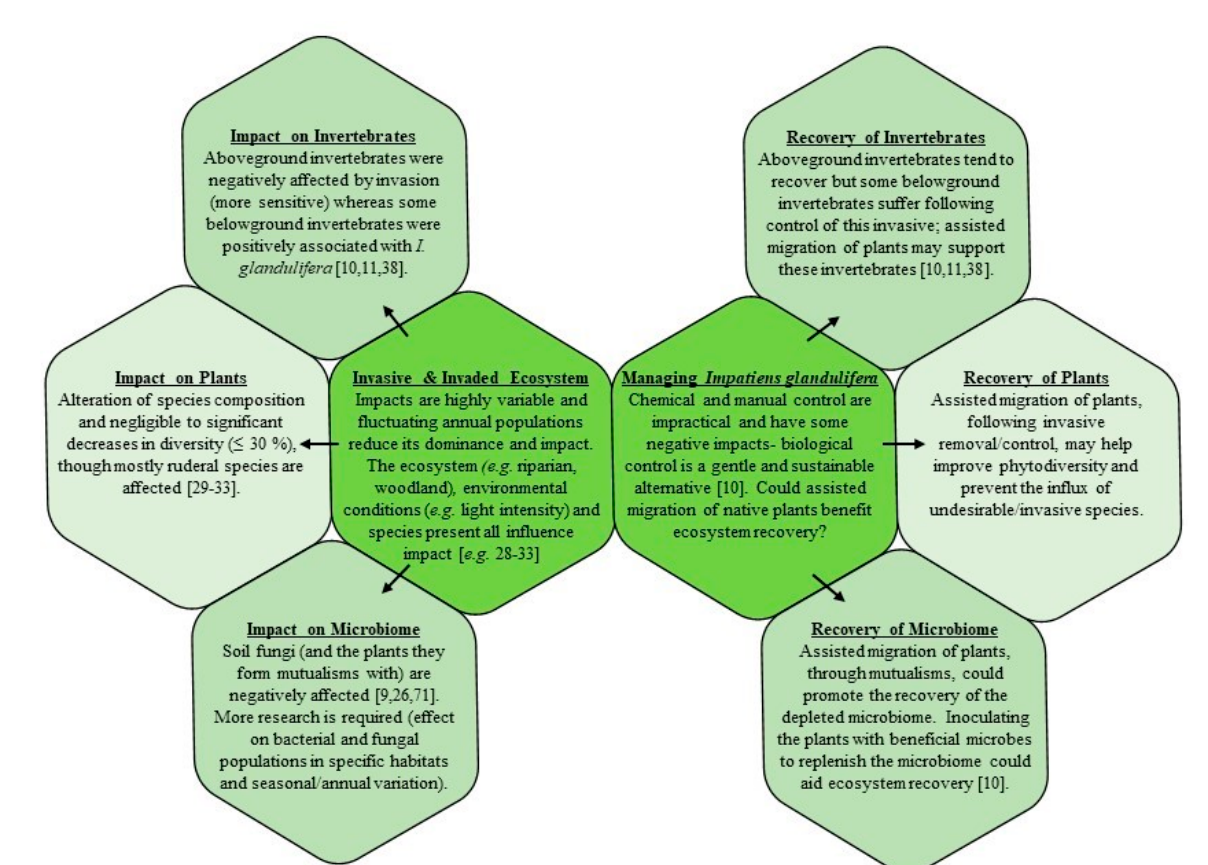
Figure 3. Summary of the impacts of I. glandulifera and management strategies. Ecosystem-specific impacts need to be considered when designing control strategies (management or eradication). Both negative and positive impacts need to be considered, alongside potential applications (e.g., bioremediation [45], bioenergy [46], biopharmaceuticals/phytotherapy [47,48,104,105]) some of which could contribute towards funding management strategies. Though it is a ‘backseat driver’ of change in ecosystems, I. glandulifera is not as damaging as some other invasive species (such as Fallopia japonica ) [33,61]. Total eradication may not be feasible, though more recently invaded forests may be easier to manage and removal of plants may still be necessary in heavily invaded areas [10,28,33]. The 2019 update to Regulation (EU) No. 1143/2014 refers to the restoration of the ecosystems damaged by invasion and biological control is a promising management strategy which crucially does not cause further disturbance/damage (physical control can destabilise soil, increasing erosion risk). Assisted migration of native plants may facilitate restoration and help prevent an influx of invasive/weed species [10,51 ] .